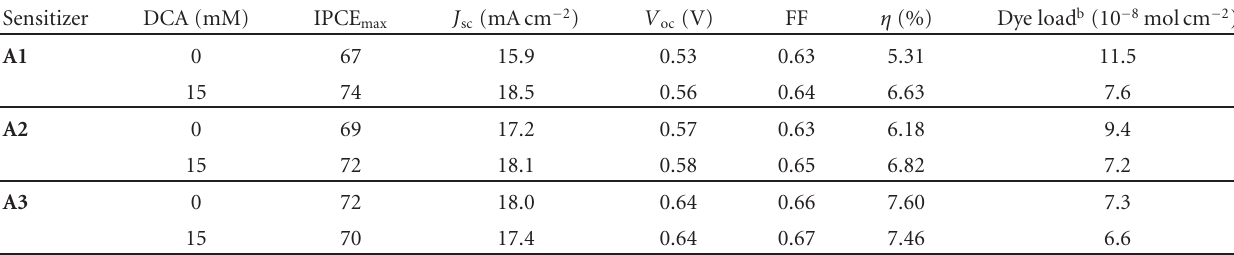
Table 2: Adsorbed amount of dye and cell performance a of A1, A2, and A3 sensitizers with and without DCA. Sensitizer